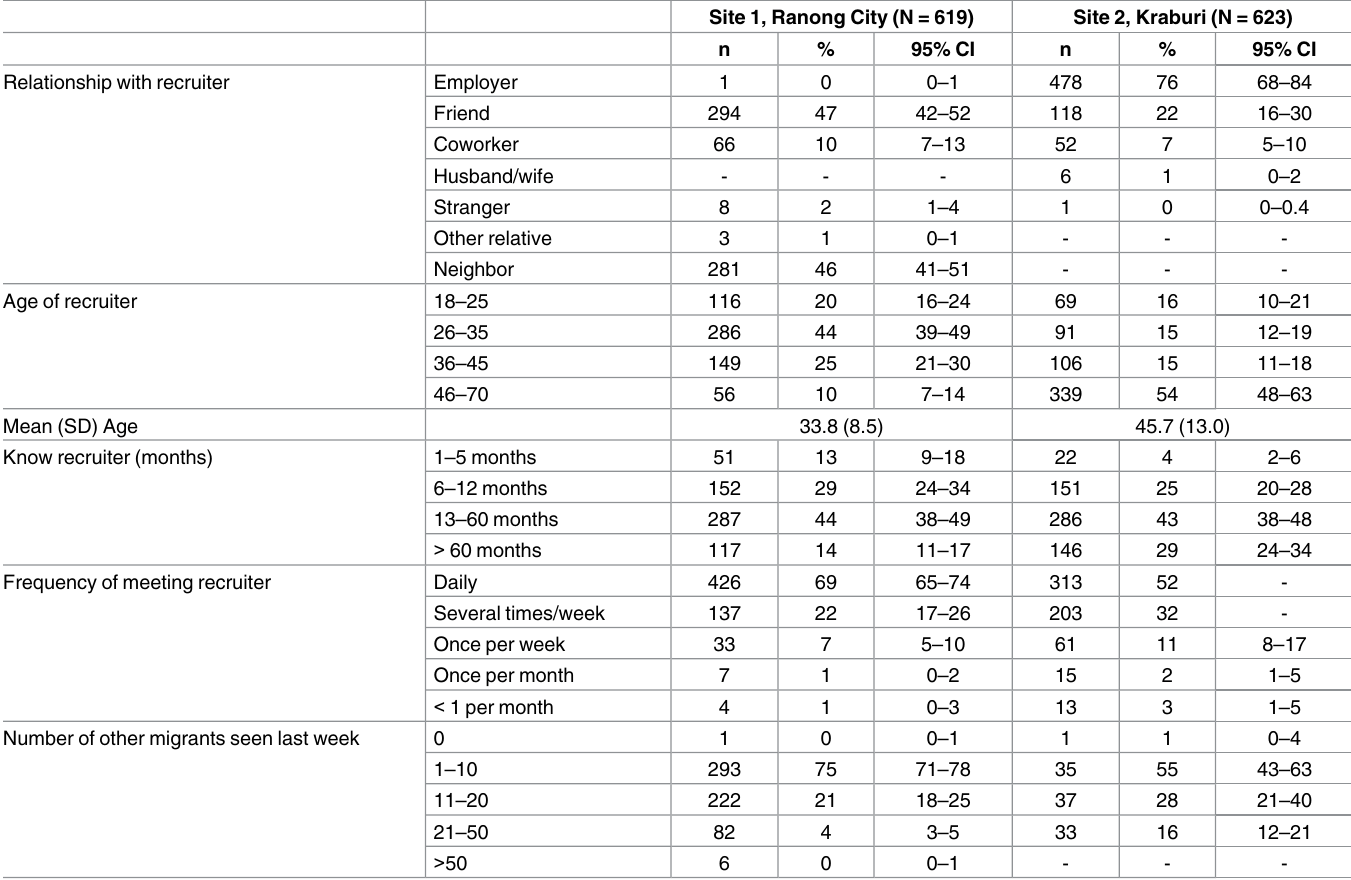
Table 7. RDS-weighted estimates of network characteristics by